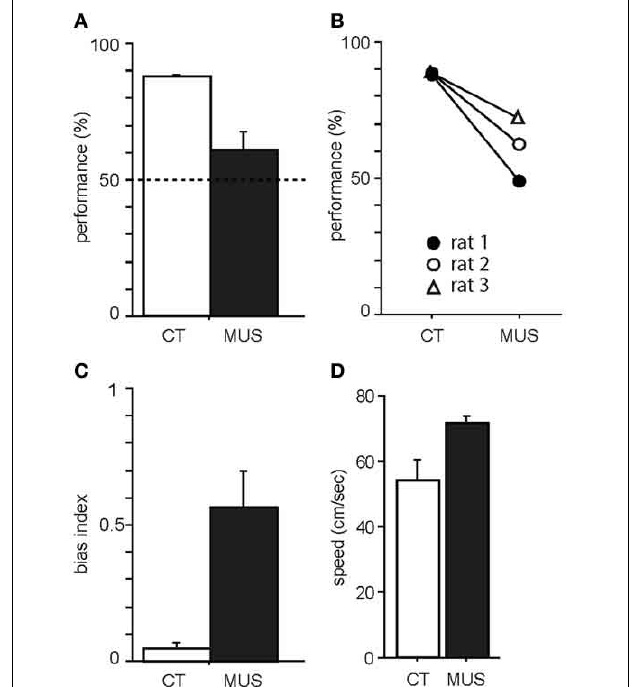
FIGURE 3 | Behavioral performance in the task. (A) Average percent correct scores in CT and MUS conditions. Dotted line indicates chance level. Note the significant impairment in performance in MUS compared to CT. Mean ± s.e.m. (B) Performances of individual rats. Note that all rats showed the same trend of decrease in performance under MUS. (C) Response bias in MUS condition compared to CT condition. Mean ± s.e.m. (D) Average moving speed of drug groups during the task. Mean ±